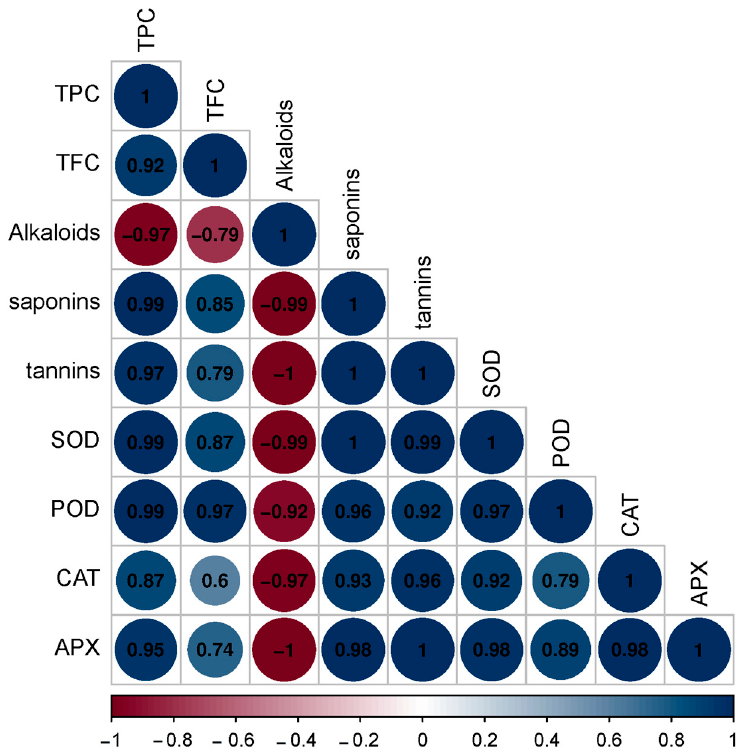
Figure 4. Antioxidant enzyme activity for the studied C. gileadensis accessions (C1: collected from Jeddah, C2: collected from Jizan and C3: collected from Riyadh). Bars with different letters indicate significant differences between accessions, expressed as the mean of three replicates ± SDs.